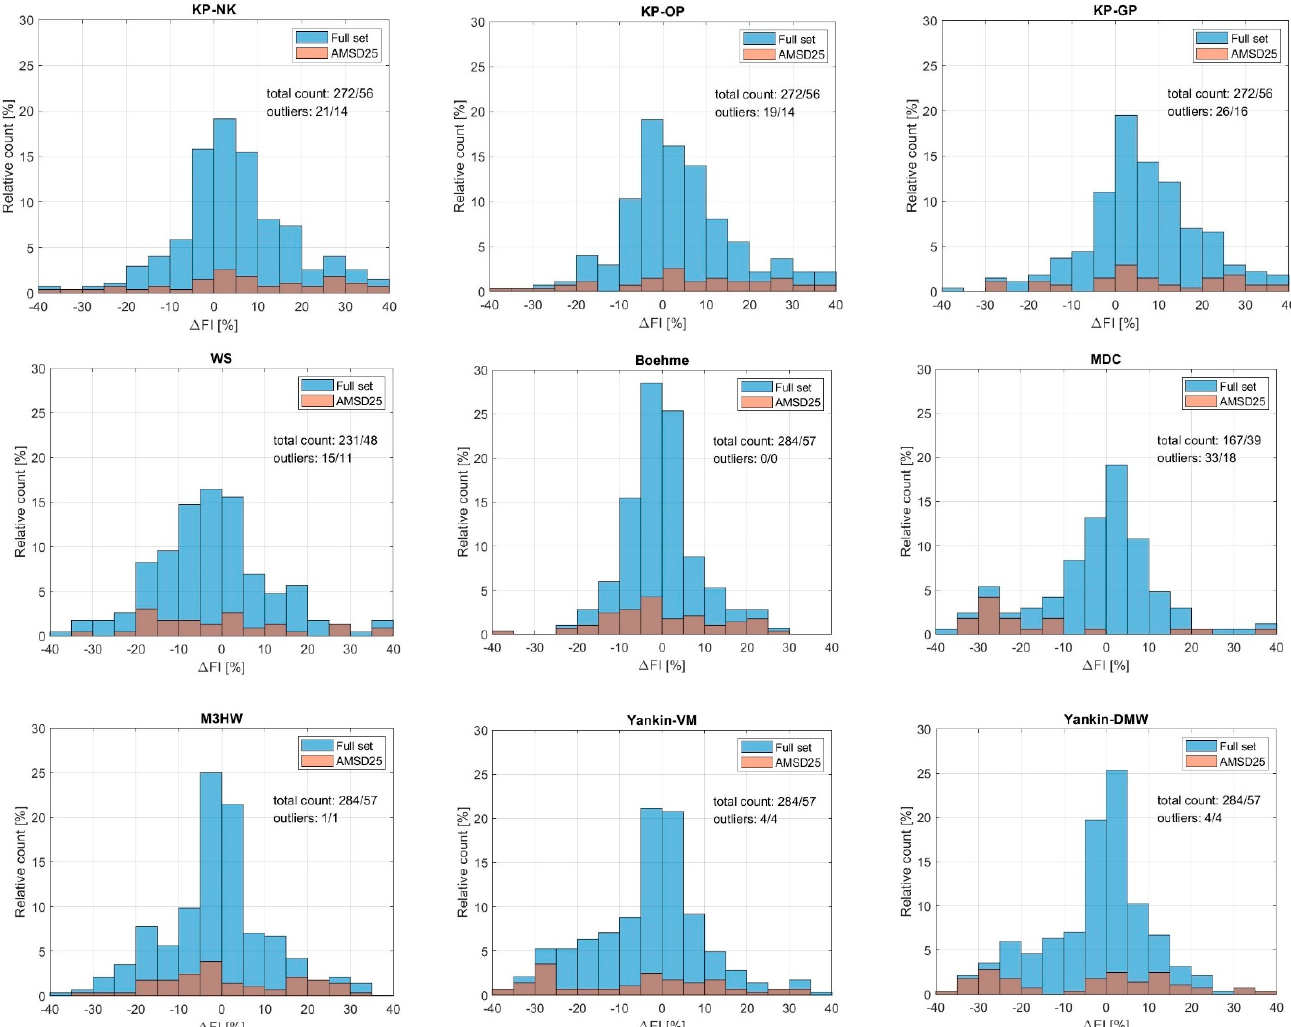
Figure 1. Histograms of ∆ FI occurrence in the FatLim full set (blue) and in the AMSD25 subset (salmon). The total count numbers refer to the number of items in each of those test sets, on which the criterion could be applied. The number of outliers describes how many more items would be depicted in the histogram if its whole range could be shown. The relative count refers to the total count of items to which the criterion was applicable and not to the entire FatLim.